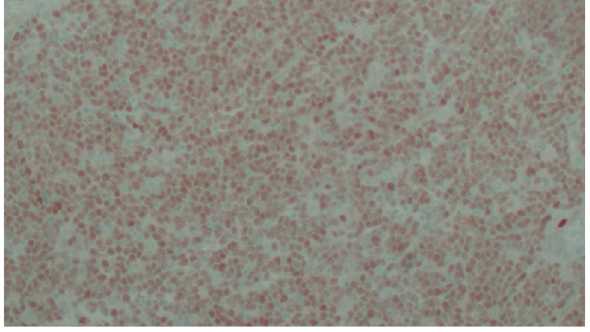
Figure 6: Immunostaining for bcl-1 (cyclin